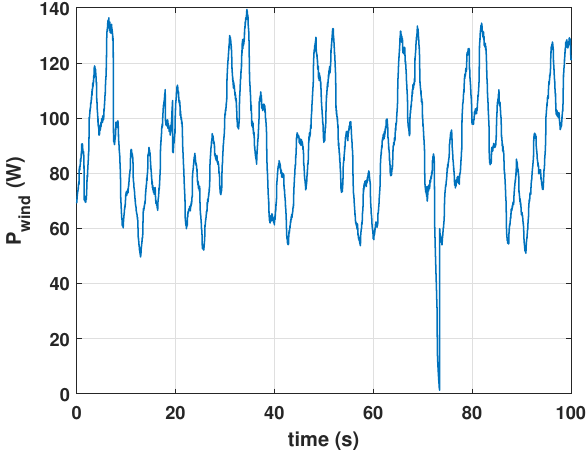
Figure 18. Output power of the PMSG.